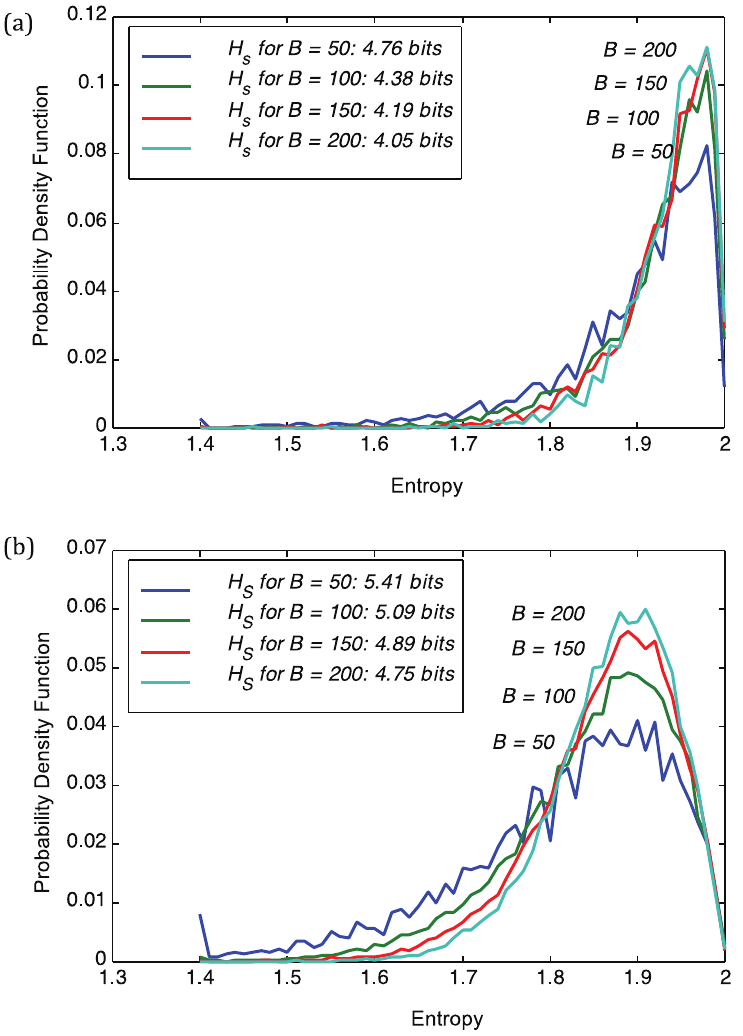
Figure 1. Sensitivity of the probability density function (pdf) of sequence entropies with respect to block size B for ( a ) the viral genome of PBCV1; and ( b ) Chlorella NC64A. We also show the superinformation H s